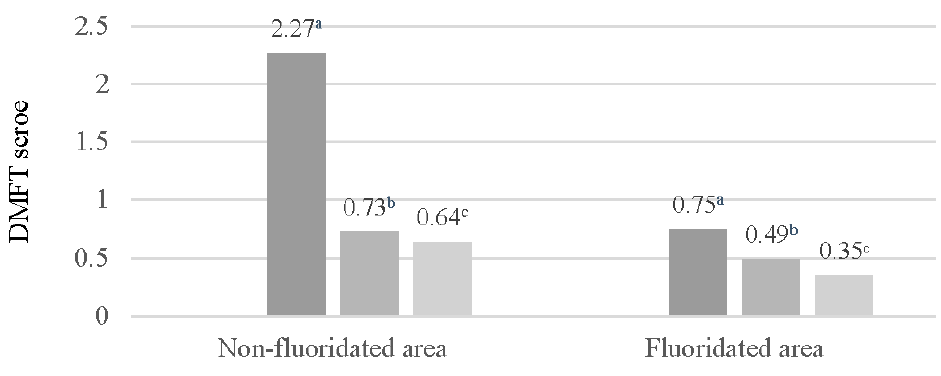
Figure 2. Distribution of decayed, missing, and filled teeth (DMFT) scores based on the householder educational levels (year). The scores were calculated from the univariate analysis of variance: a Covariates appearing in the model are evaluated at the following values: age = 9.93; b Covariates appearing in the model are evaluated at the following values: age = 8.61; c Covariates appearing in the model are evaluated at the following values: age = 8.40. The DMFT scores of 11-year-old children were compared using box plots (Figure 4), which indicated that the DMFT score distribution was divided based on the three FAS levels. The range of the box plots in the CWF area was more compact than that in the non-CWF area. The caries experience of the lowest one third in the non-CWF area had wider boxplots than that in the CWF area. The widening gap was evident between both areas. The lowest FAS groups displayed larger reduction in caries experience than the other FAS groups (Figure